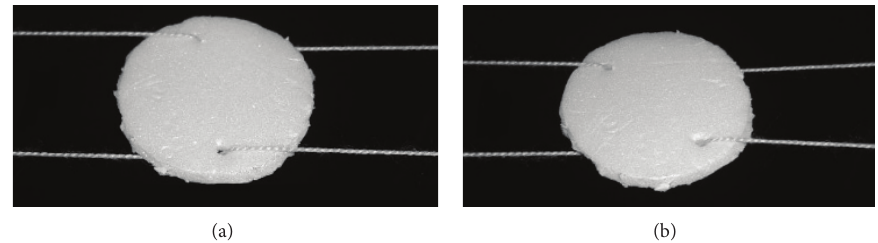
Figure 1: In vitro experiment on a cardboard disc showing disc resistance to tilt even with disc rotation.